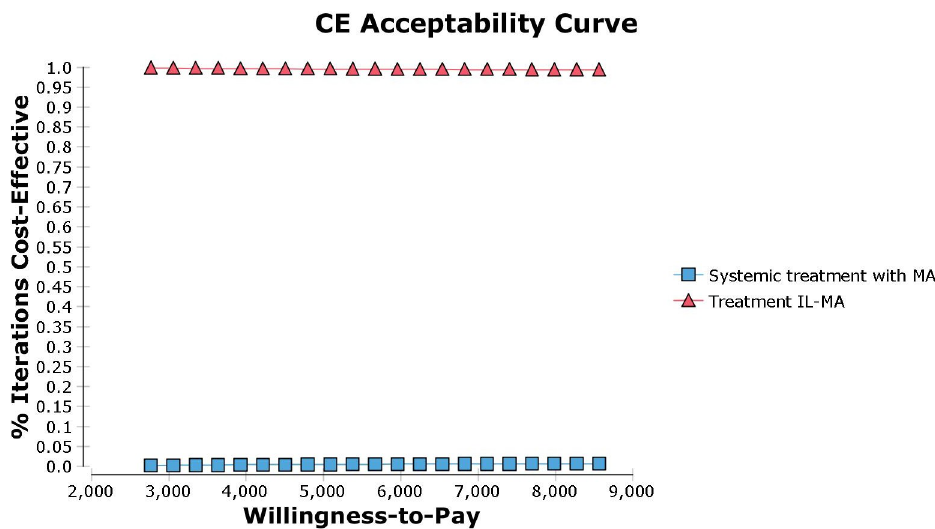
Fig 3. Cost-effectiveness acceptability curve. MA: meglumine antimoniate; IL-MA: meglumine antimoniate intralesional